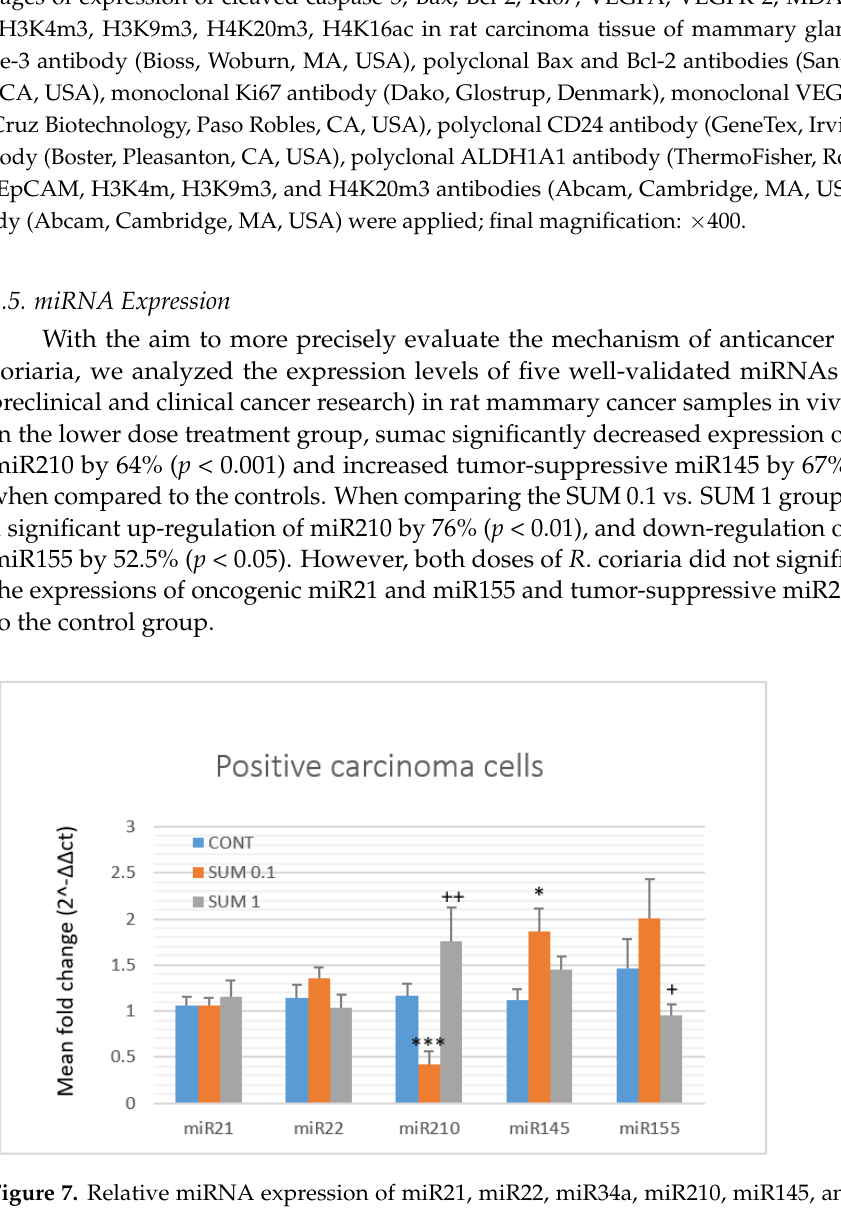
Figure 6. Representative images of expression of cleaved caspase-3, Bax, Bcl-2, Ki67, VEGFA, VEGFR-2, MDA,